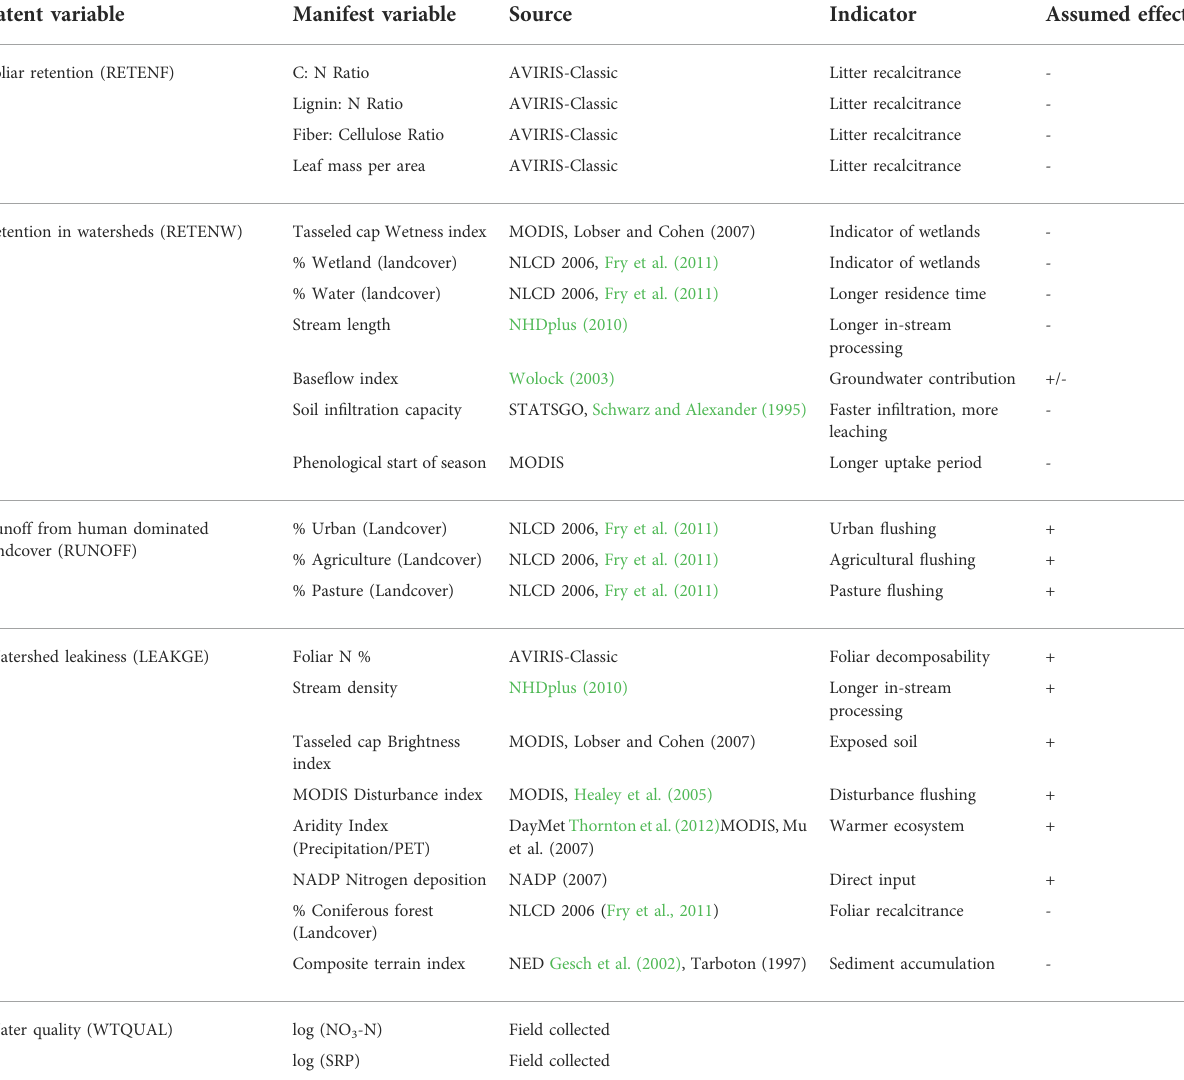
TABLE 1 Variables used in the study, sources, and basic hypotheses (±effect) associated with each; we consider an effect negative when it mitigates water quality indicators (i.e., reduces export), vice-versa for